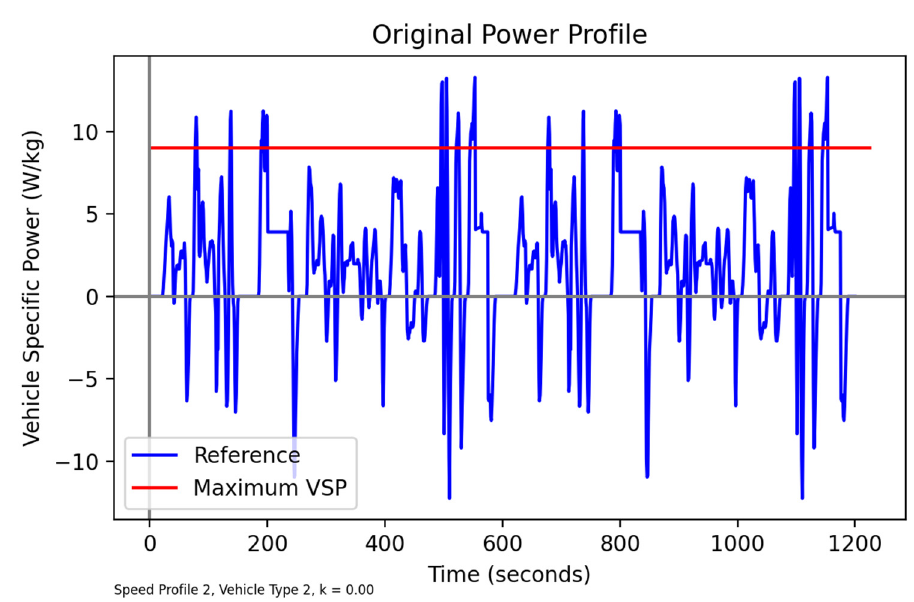
Figure 2. Implied Vehicle Specific Power for an electric quadricycle following speed profile stipulated in WMTC Reference Cycle 2 (Flat terrain).